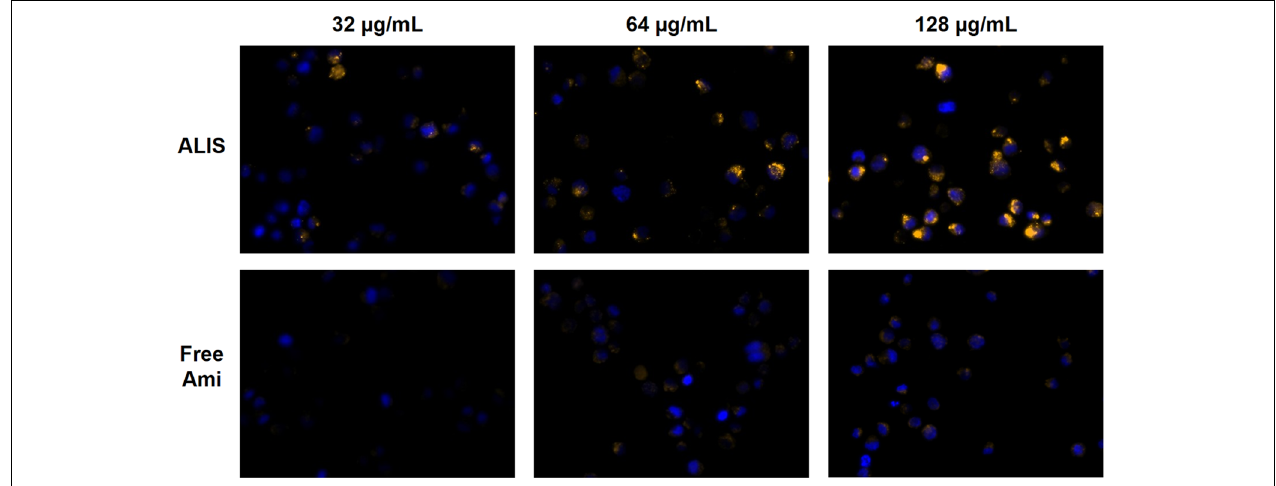
FIGURE 4 | Visualization of liposomal and free amikacin uptake in human macrophages by fluorescence microscopy. ALIS demonstrated higher uptake into differentiated THP-1 macrophages than free amikacin at each concentration. Macrophages were exposed to increasing concentrations of either liposomal or free amikacin (0.44% labeled with TAMRA) for 24 h and then TAMRA fluorescence was visualized by a Zeiss Axio fluorescence microscope (400 × magnification) using constant settings for all experimental conditions. Yellow: TAMRA amikacin; Blue: DAPI-stained DNA.